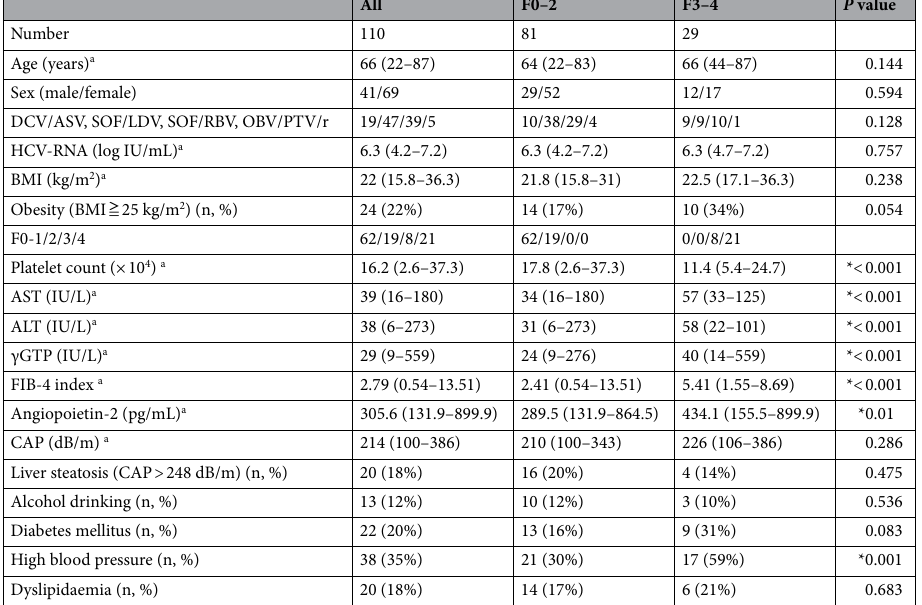
Table 1. Baseline characteristics of patients. HCV hepatitis C virus, BMI body mass index, AST aspartate aminotransferase, ALT alanine aminotransferase, γGTP γ-glutamyl transpeptidase, FIB-4 fibrosis 4, CAP Controlled Attenuation Parameter. a Data are shown as median (range) values. *Statistically significant difference, P < 0.05.